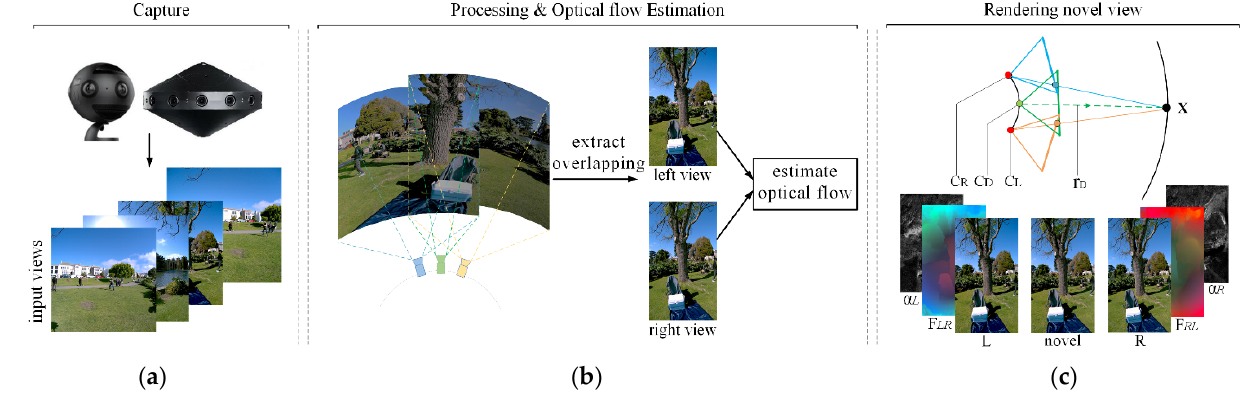
Figure 1. Overview of our approach. ( a ) Capture: experimental data are acquired by these two devices. ( b ) Processing and optical flow estimation: we divide the approximate projection area according to the angular space and calculate the optical flow of each pair of adjacent cameras to establish a dense correspondence (in Section 3.2). ( c ) Rendering: a blending algorithm combining an optical flow and alpha map is proposed to synthesize the view of novel viewpoints (in Section 3.3).